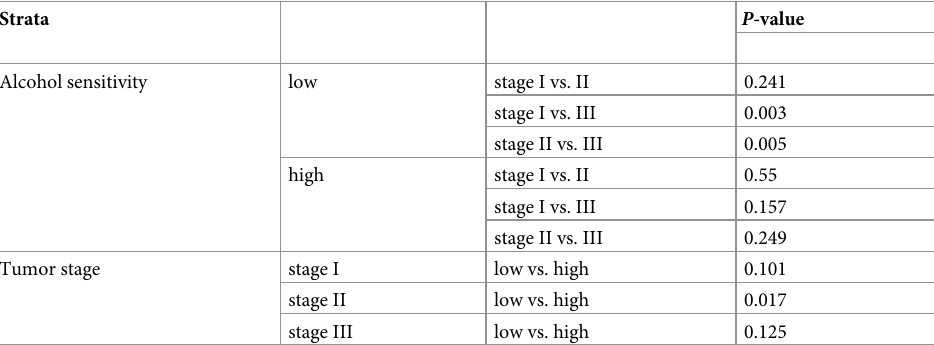
Table 3. Differences of bone metastases between stages in patients stratified by alcohol sensitivity and between sensitivities in patients stratified by tumor stages.